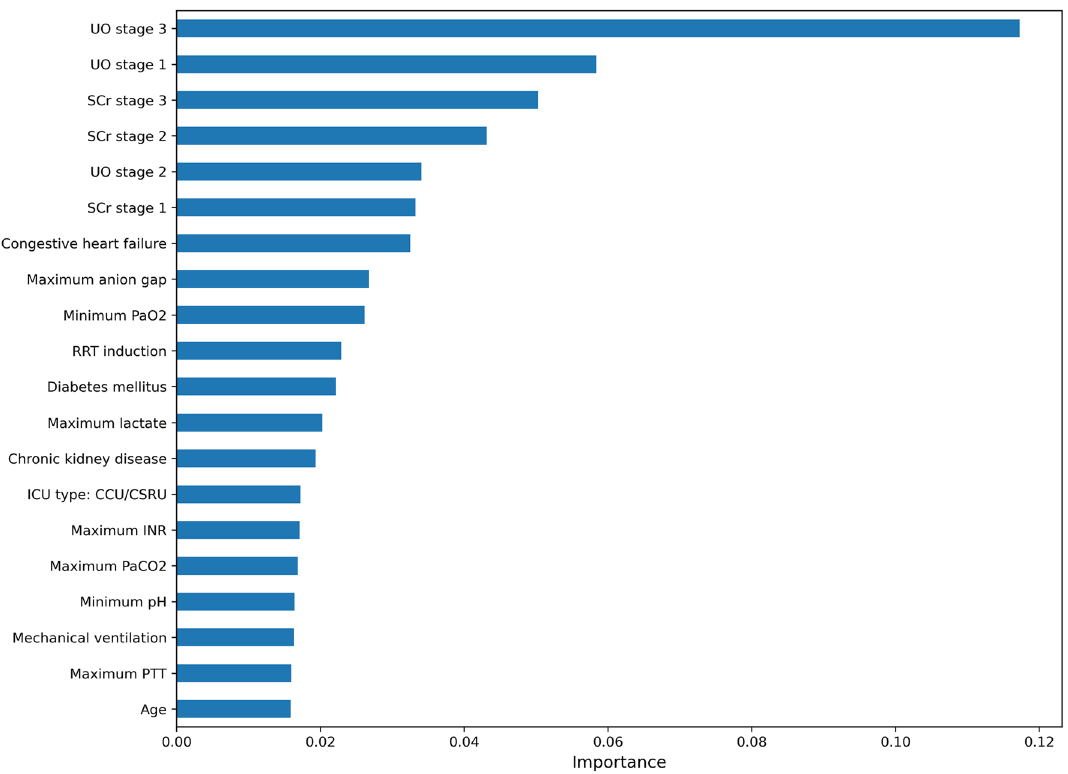
Figure 3. The top 20 important features derived from the XGB model. UO, urine output; SCr, serum creatinine; PaO 2 , partial pressure of oxygen; RRT, renal replacement therapy; ICU, intensive care unit; CCU, coronary care unit; CSRU, cardiac surgery recovery unit; INR, international normalized ratio; PaCO 2 , partial pressure of carbon dioxide; PTT, partial thromboplastin time.